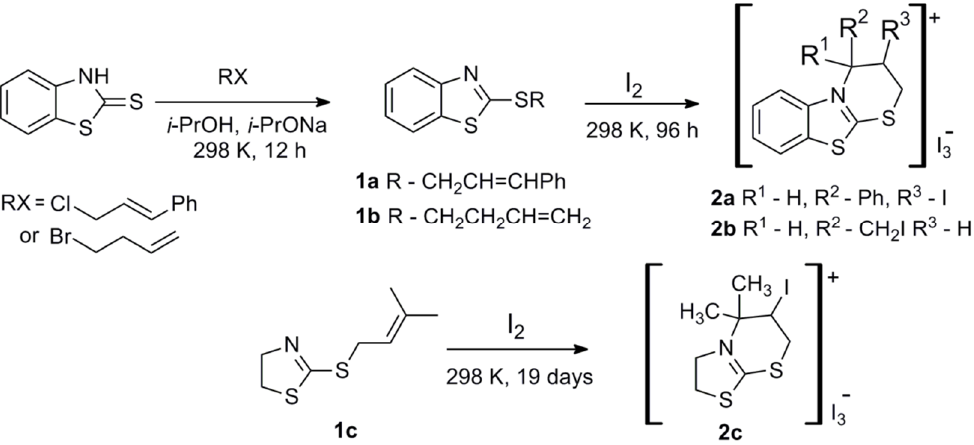
Figure 1. Iodocyclization of compounds 1a–c resulting in corresponding triiodides 2a–c .